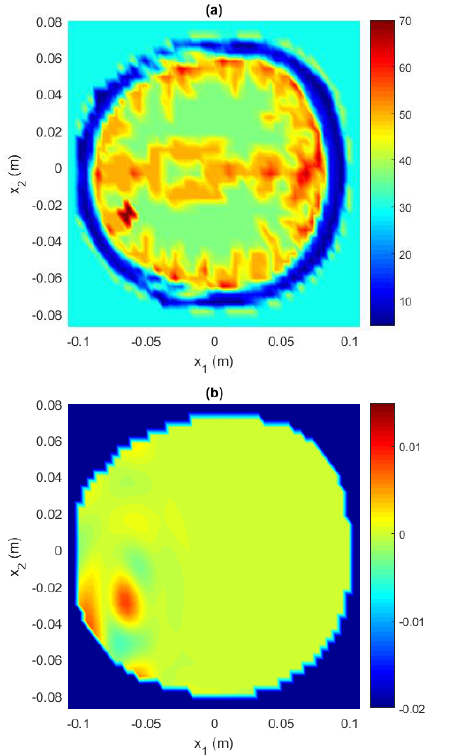
Figure 5: (a) Real parts of relative dielectric permittivity of 2-D head model with blood region, (b) Detection of blood region (Real parts of 𝛿𝑣